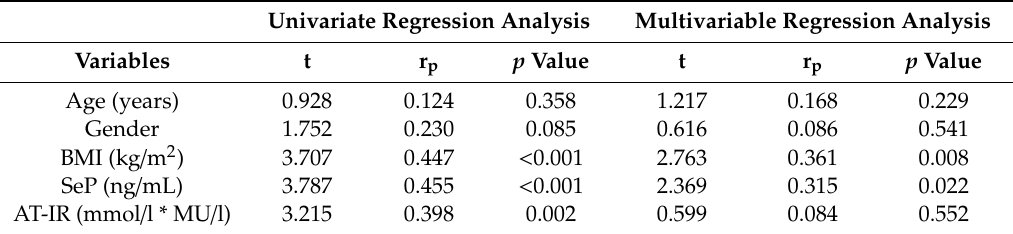
Table 4. Univariate and multivariable regression for the identification of the metabolic variables associated with the degree of hepatic fibrosis.